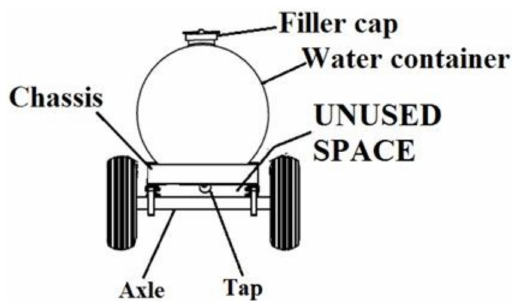
Figure 1. Simple design of an agricultural water